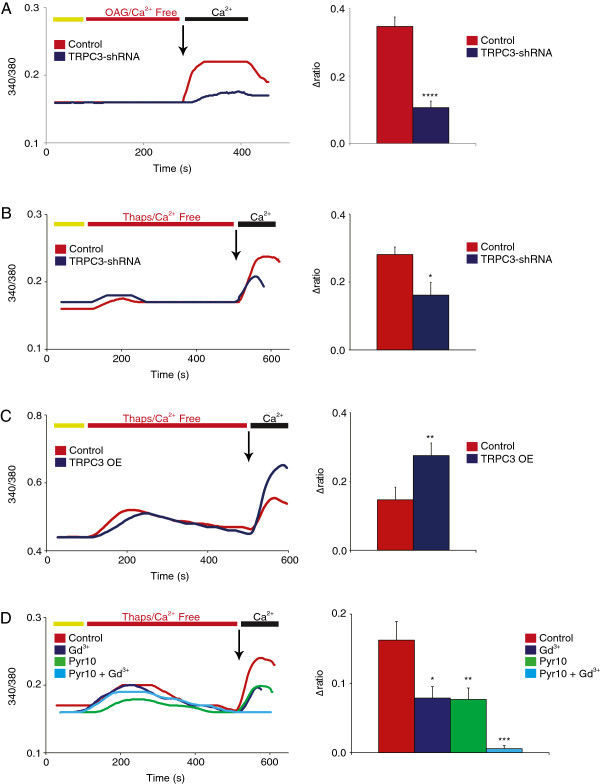
TRPC3 participates in SOCE in DRG neurons. (A) TRPC3 shRNA-mediated knockdown was validated in a functional assay to determine the inhibitory effect of the shRNA on OAG-evoked calcium entry in DRG neurons (n = 9-11, P < 0.0001). (B) shRNA-mediated knockdown of TRPC3 in the SOCE assay clearly shows a strong contribution of this channel to the overall calcium influx. A decrease of approximately 42% is observed (n = 13-27, P < 0.05). (C) Heterologous overexpression of TRPC3 (OE) in DRG neurons produced a drastic increase in SOCE-mediated calcium influx of approximately 85% (n = 16-19, P < 0.01). (D) The inhibition of TRPC3 activity by the selective blocker Pyr10 (10 μM, 15 min) also resulted in a strong decrease of SOCE activity, with calcium influx dropping approximately 50% (n = 34-39, P < 0.01). The cumulative inhibition of both Orai and TRPC3 with Gd3+ and Pyr10, respectively, almost completely abolished SOCE response in DRG (n = 18-21, P < 0.001).